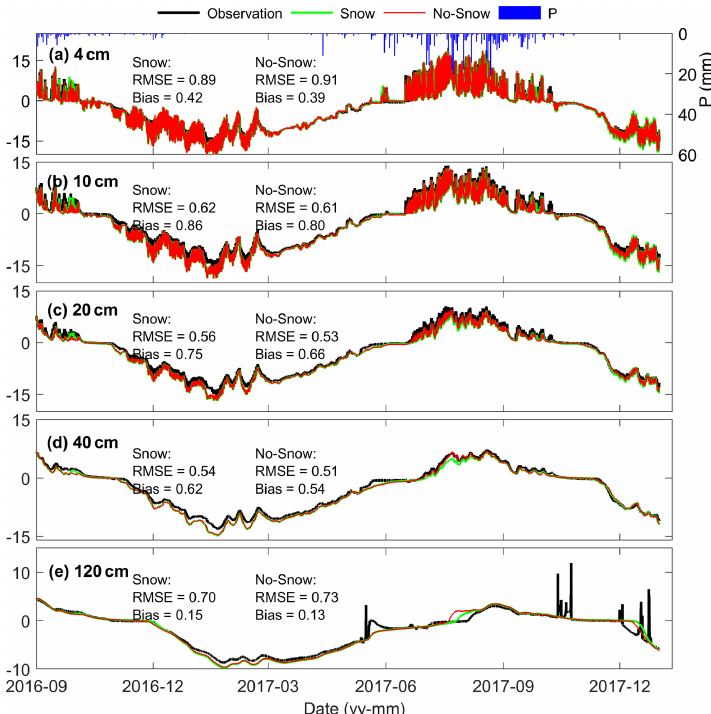
Figure B5. Observed and estimated soil temperature at various soil layers using the model with and without the snow module.